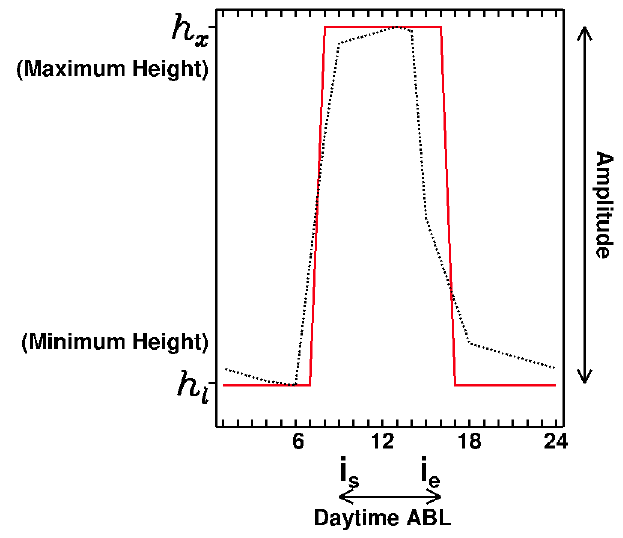
Fig. 9. Factors characterizing the time evolution of boundary layer thickness. Minimum height, maximum height, amplitude are indi- cated for top-hat shape (red).